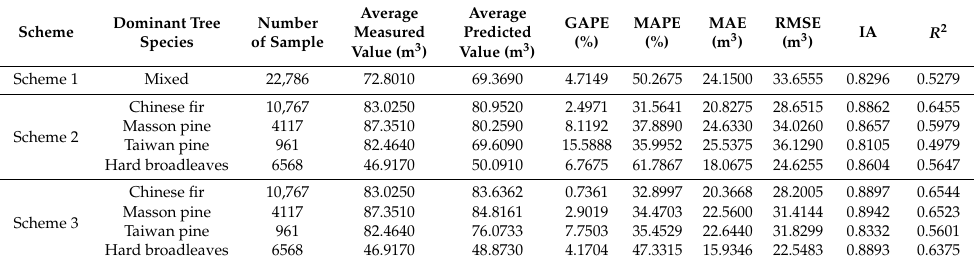
Table 6. Detailed performance metrics of the prediction results for each